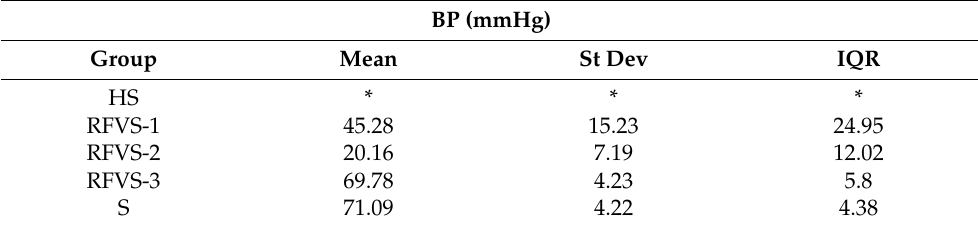
Table 1. BP test in study arm 1.